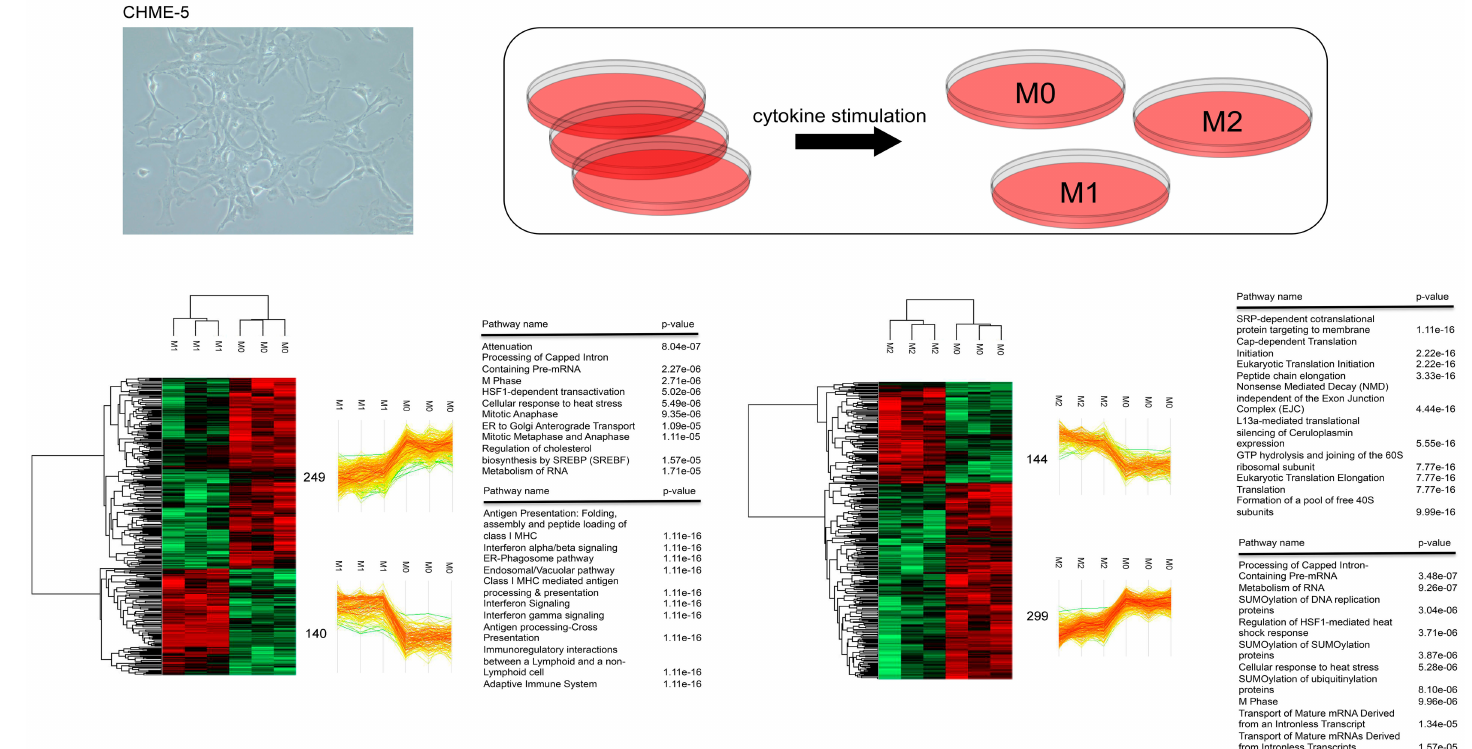
Figure 2. Mass spectrometry analysis of microglia cells. CHME-5 cells were treated with IFN- γ or IL-4 to induce an M1-like or M2-like phenotype, respectively. Heat-map of whole protein abundance profiles following hierarchical clustering based on Euclidean distance of significantly regulated proteins. Three biological replicates are shown for control cells (M0), and for cells stimulated with IFN- γ (M1) and IL-4 (M2). Green color corresponds to a decreased expression level and red color to an increased expression level. Distinct clusters for M0 and M1 samples, and M0 vs. M2 samples are highlighted. Numbers indicate the proteins in each cluster. Proteins in each cluster were analyzed using REACTOME. Top 10 enriched networks identified by functional analysis of di ff erentially expressed proteins and ranked according to p -value were